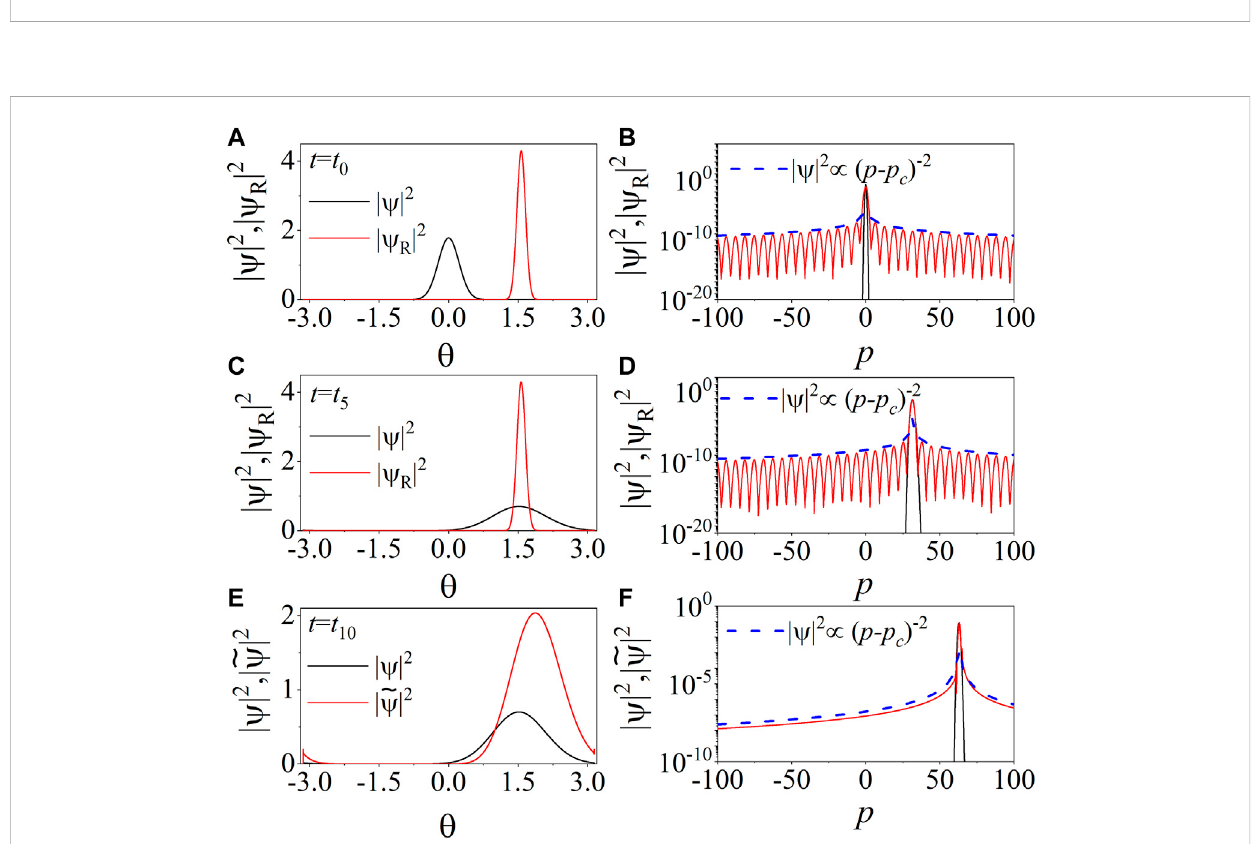
the state | ψ R ( t 0 ) 〉 . The reason for the formation of power-law decayed wavefunction has been uncovered in Ref. 65.